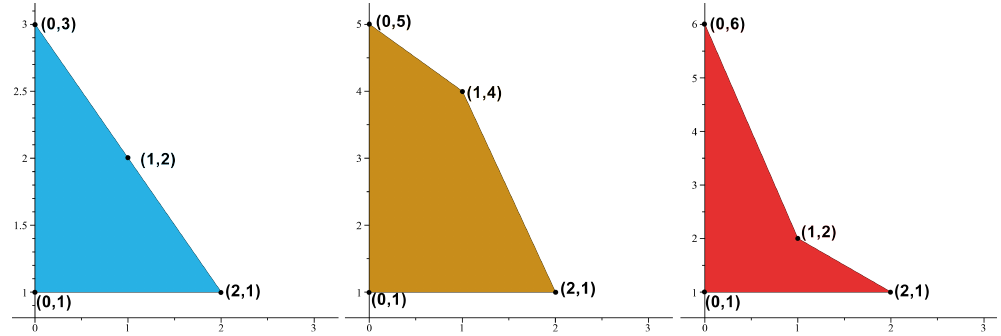
Figure 5. 3-gonal (triangular), 4-gonal convex, 4-gonal non-convex